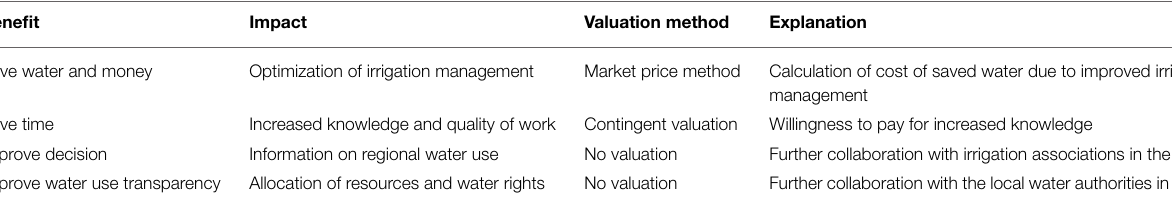
TABLE 1 | Benefits and possible valuation